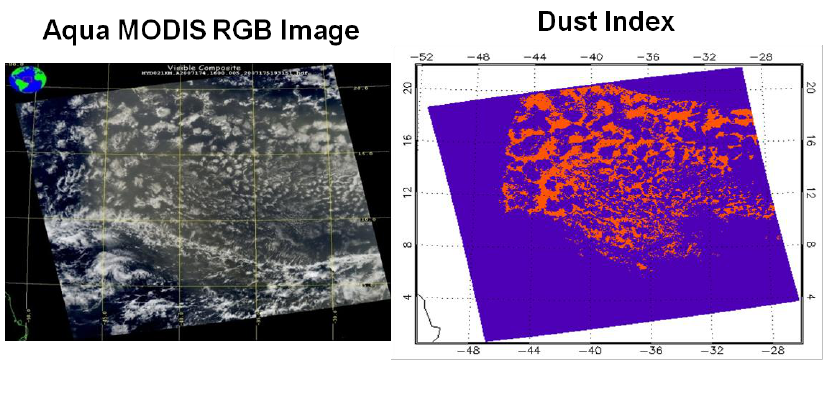
Figure 17. A Sahara dust outbreak is flowing across the Atlantic Ocean above cloud in a RGB image (yellowish color) of left panel and the corresponding dust index (red) of right panel. This is an Aqua MODIS granule on June 23, 2007 at 16:00